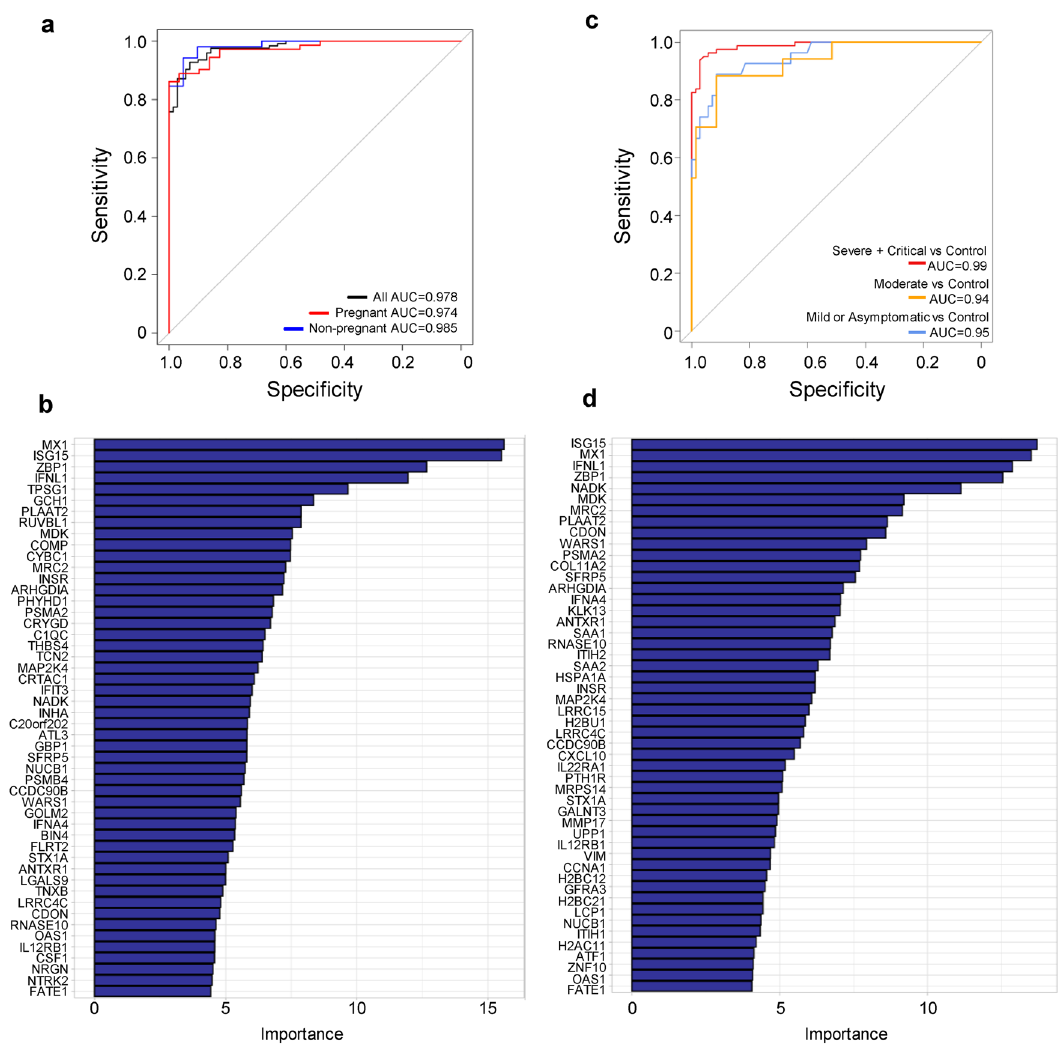
Fig. 8 The plasma proteome allows for the identi fi cation of COVID-19 patients and can distinguish mild and severe diseases. a Receiver operating characteristic (ROC) curves for discrimination of all COVID-19 cases from all controls (black curve), only pregnant COVID-19 cases from pregnant controls (red curve), and only non-pregnant COVID-19 cases from non-pregnant controls (blue curve). b Bar plot displaying the relative importance of the top 50 proteomic predictors for identifying all COVID-19 cases. c ROC curves for discrimination of severe/critical cases from controls (red curve), moderate cases from controls (yellow curve), and asymptomatic/mild cases from controls (blue curve). Data from both pregnant and non-pregnant cases are included in this analysis. d Bar plot displaying the relative importance of the top 50 proteomic predictors for distinguishing severe/critical COVID-19 cases from